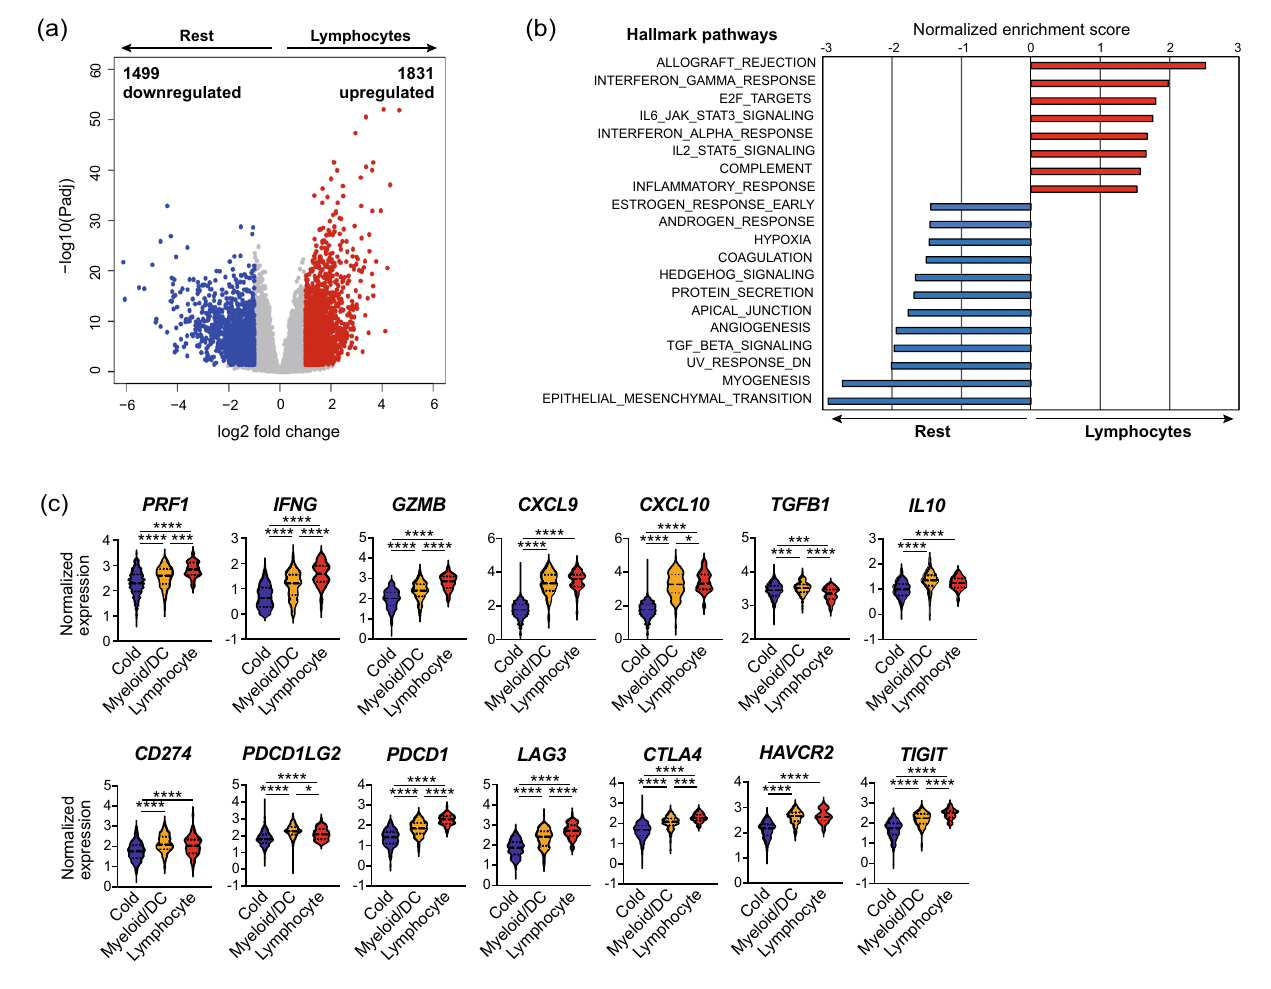
Figure 3. The lymphocyte signature correlated with activated cytotoxic T cell response. ( a ) Volcano plot of differentially expressed genes in the lymphocyte signature of TCGA cohort. Red dots represent upregulated genes (Padj < 0.05, log2FC > 1), whereas blue dots represent downregulated genes (Padj < 0.05, log2FC < − 1). ( b ) Upregulated and downregulated hallmark pathways in the lymphocyte signature obtained by GSEA (FDR < 0.05). ( c ) Violin plots of normalized expression of immune-related genes. GSEA Gene set enrichment analysis, FDR False discovery rate. *, P < 0.05; ***, P < 0.001; ****, P <